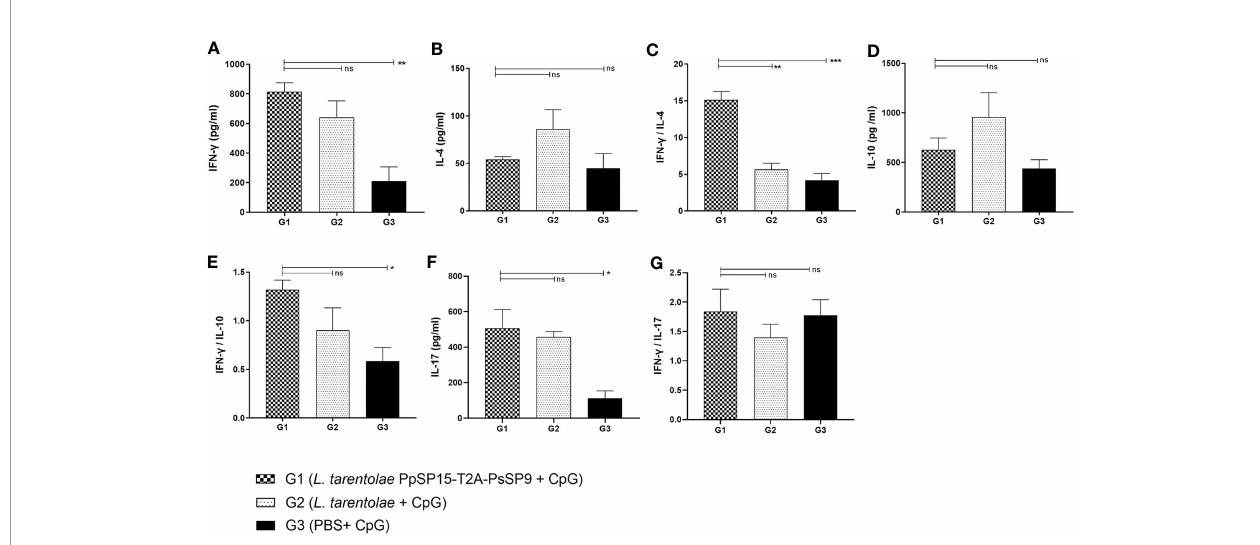
FIGURE 2 | Before challenge analysis of cytokine production in vaccinated and control mice by ELISA. After the last immunization and prior to infectious challenge, all mice (n=3-4 per group) were sacri fi ced and single splenocytes from each individual BALB/c mouse were re-stimulated by L. tarentolae PpSP15-T2A-PsSP9 F/T antigen. (A) IFN- g production, (B) IL-4 production, (C) IFN- g /IL-4 ratio, (D) IL-10 production, (E) IFN- g /IL-10 ratio, (F) IL-17 production, (G) IFN- g /IL-17ratio. For all cytokines, the results are presented as mean ± SE (in pg/ml). Data are representative of two independent experiments. Student t-test was used for statistical analysis (* p < 0.05, ** p < 0.01, *** p < 0.001, ns, non-signi fi